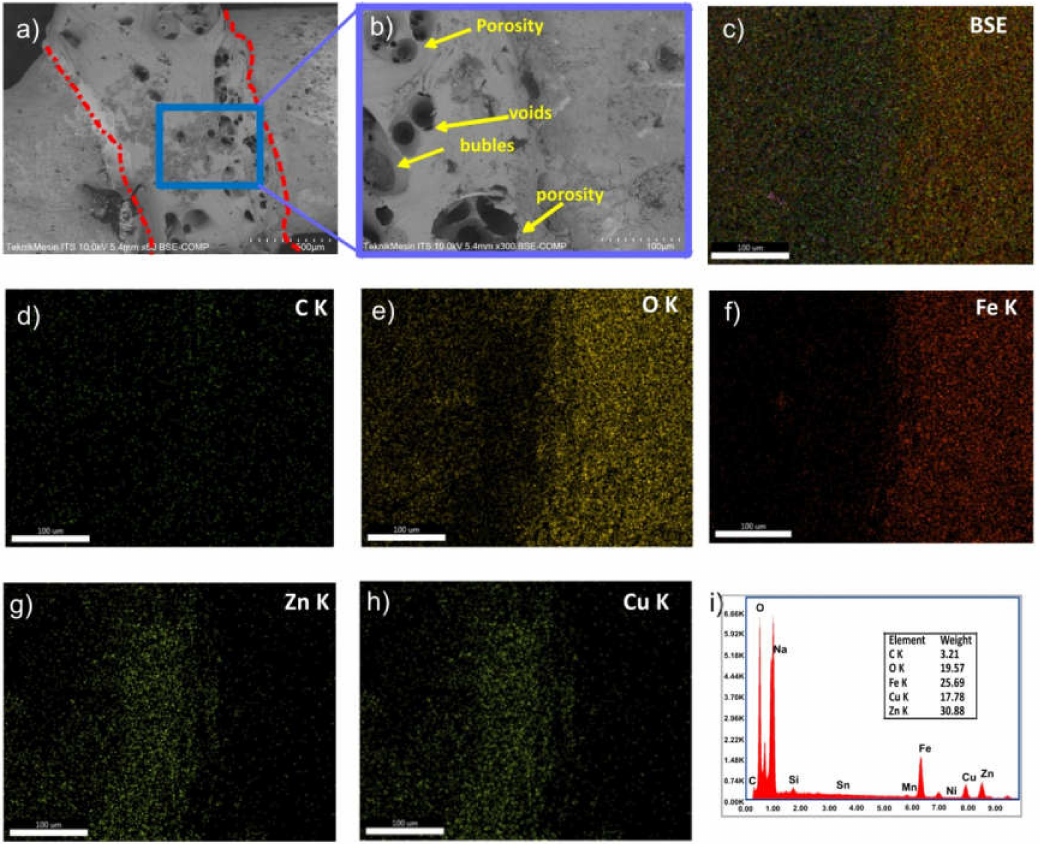
Figure 7. ( a ) The micrograph of α 2 using SEM with a 50x magnification, ( b ) 300x magnification, ( c ) color composite of SEM / EDS maps (backscattered electron), ( d ) map of O, ( e ) map of C, ( f ) map of F, ( g ) map of Cu, ( h ) map of Zn using EDS, ( i ) Elements composition of welded joint.